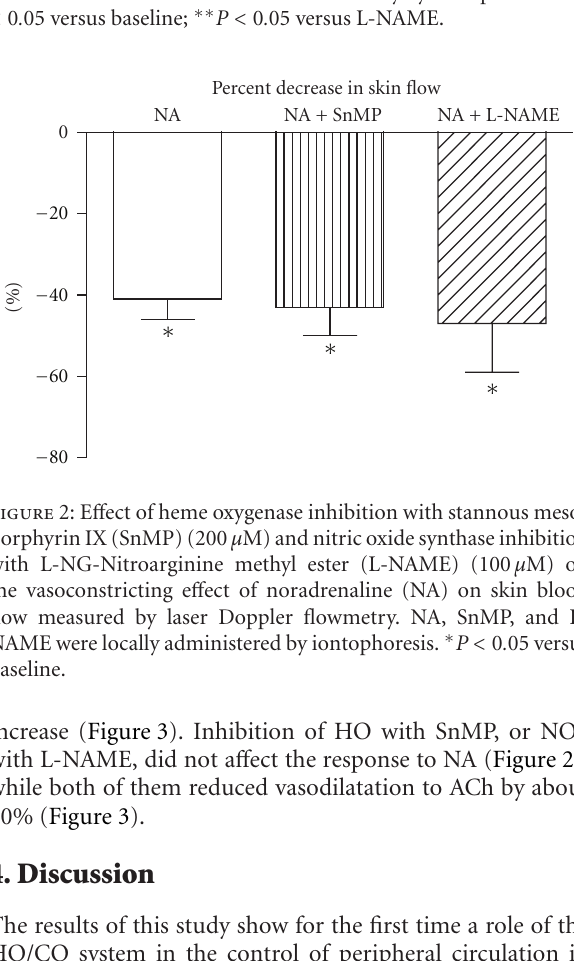
Figure 1: E ff ect of heme oxygenase inhibition with stannous meso- porphyrin IX (SnMP) (200 µ M), of nitric oxide synthase inhibition with L-NG-Nitroarginine methyl ester (L-NAME) (100 µ M), and of both, on skin blood flow measured by laser Doppler flowmetry. SnMP and L-NAME were administered locally by iontophoresis. ∗ P < 0 . 05 versus baseline; ∗∗ P < 0 . 05 versus L-NAME.